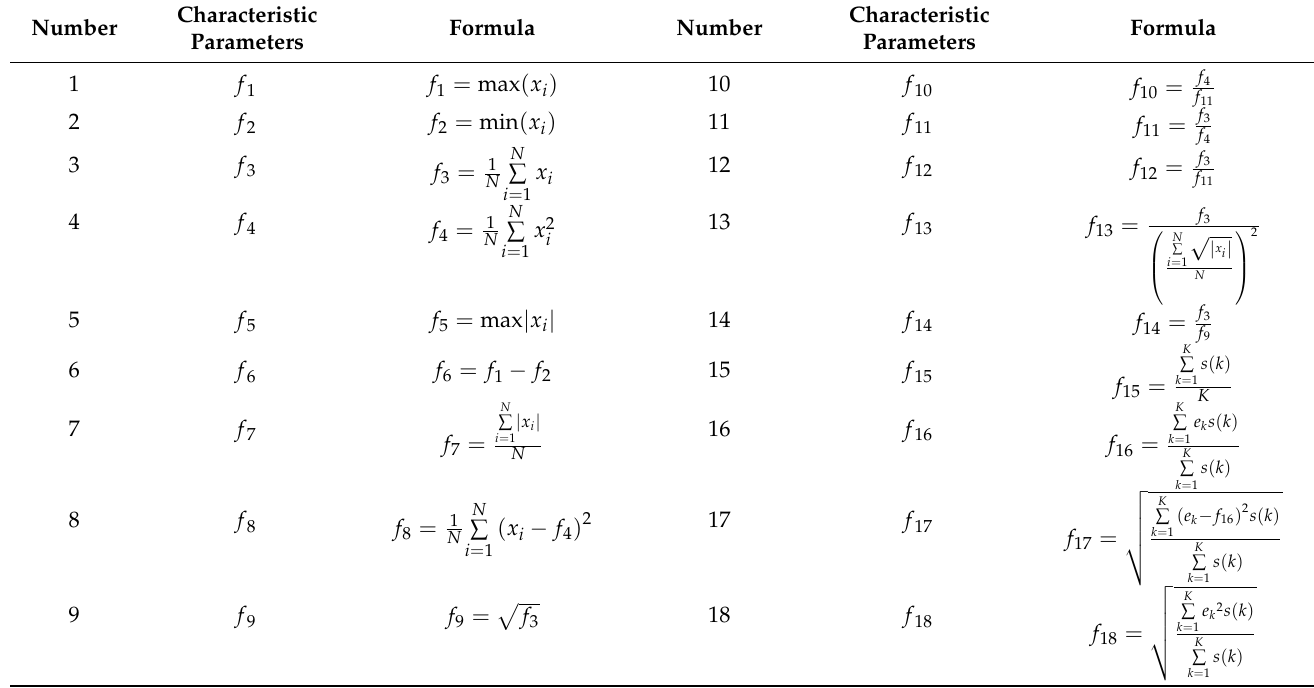
Table 1. The formulas correspond to the characteristic parameters.